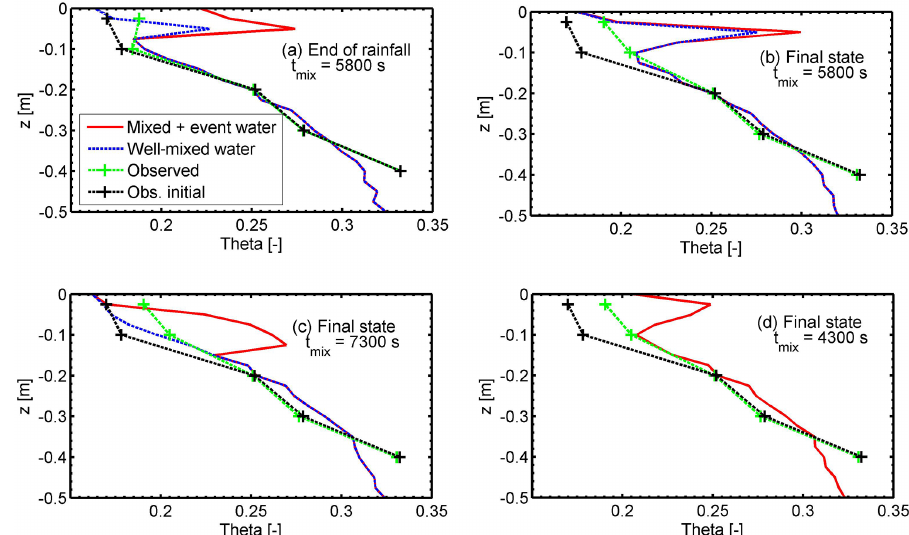
Figure 10. Non-equilibrium simulations compared against observed soil moisture values, for t mix = 5800s after the rainfall event (a) and at the end of the simulation (b) . Panels (c) and (d) present the final state for t mix = 7300s and t mix = 4300s,